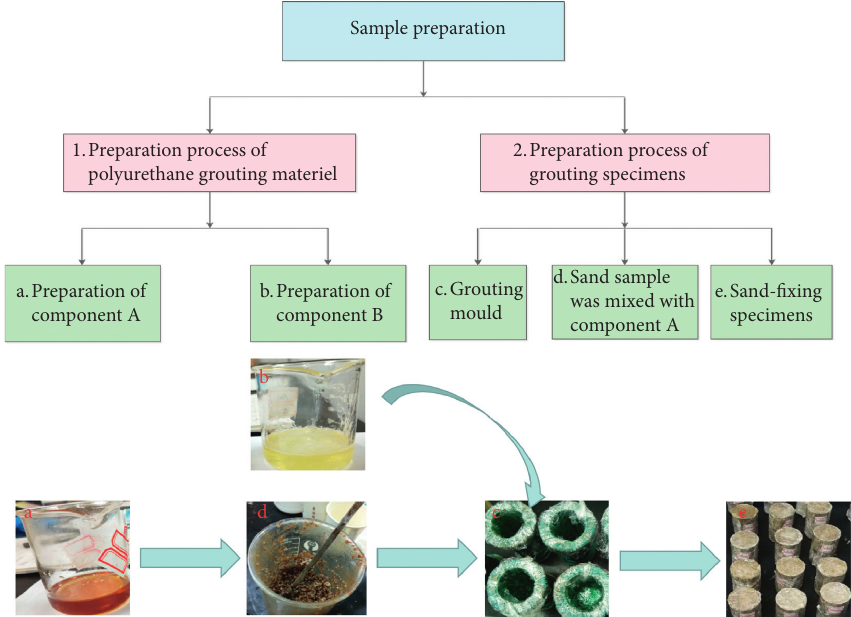
Figure 1: Sample preparation process.